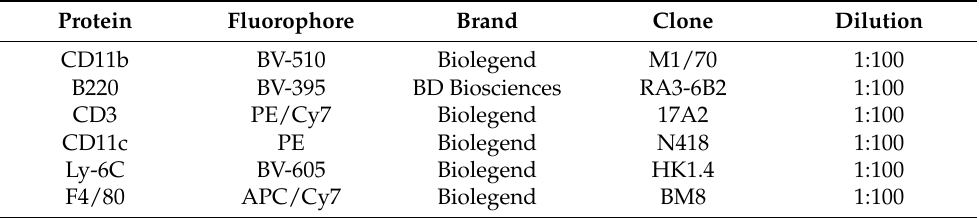
Table 2. Monoclonal antibodies used to differentiate the blood subpopulations in the mice